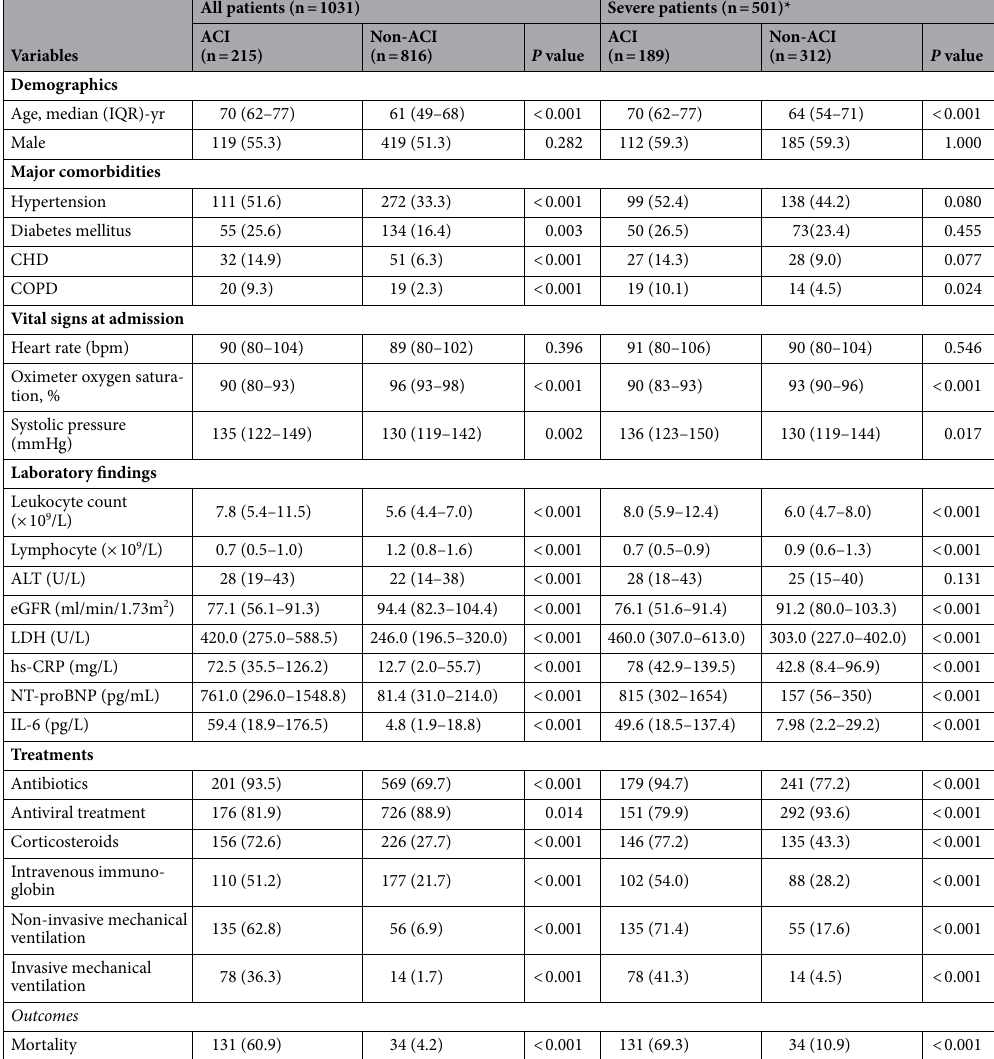
Table 2. Comparisons between patients with acute cardiac injury (ACI) and those without ACI. Data are expressed as median (interquartile range) or number (%), where appropriate unless specifically indicated. *For analysis purpose, severe and critically ill types of COVID-19 were defined as “severe” type in the present study. ACI, acute cardiac injury; CHD, coronary heart disease; COPD, chronic obstructive pulmonary disease; ALT, alanine transaminase; LDH, lactate dehydrogenase; IL-6,